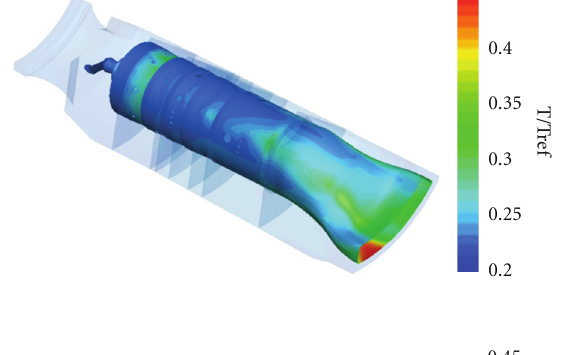
Figure 10: Velocity vectors and Mach numbers at the second primary hole section.